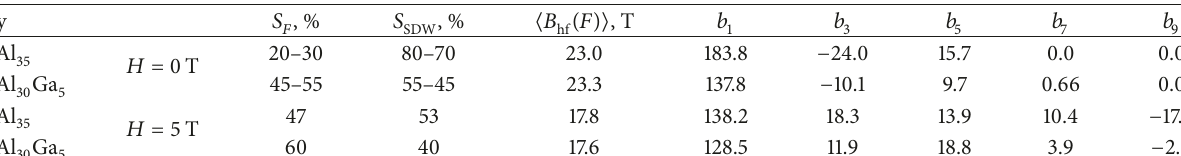
Table 2: The results of the spectra fitting for the Fe 65 Al 35 and Fe 65 Al 30 Ga 5 alloys without external field and in an applied magnetic field 𝐻 ext = 5T: the fraction of the ferromagnetic type phase 𝑆 𝐹 , the SDW fraction 𝑆 SDW , the average HFF of the ferromagnetic subsystem ⟨𝐵 hf (𝐹)⟩ , and the harmonic amplitudes b , describing the SDW by formula (1). 2n+1